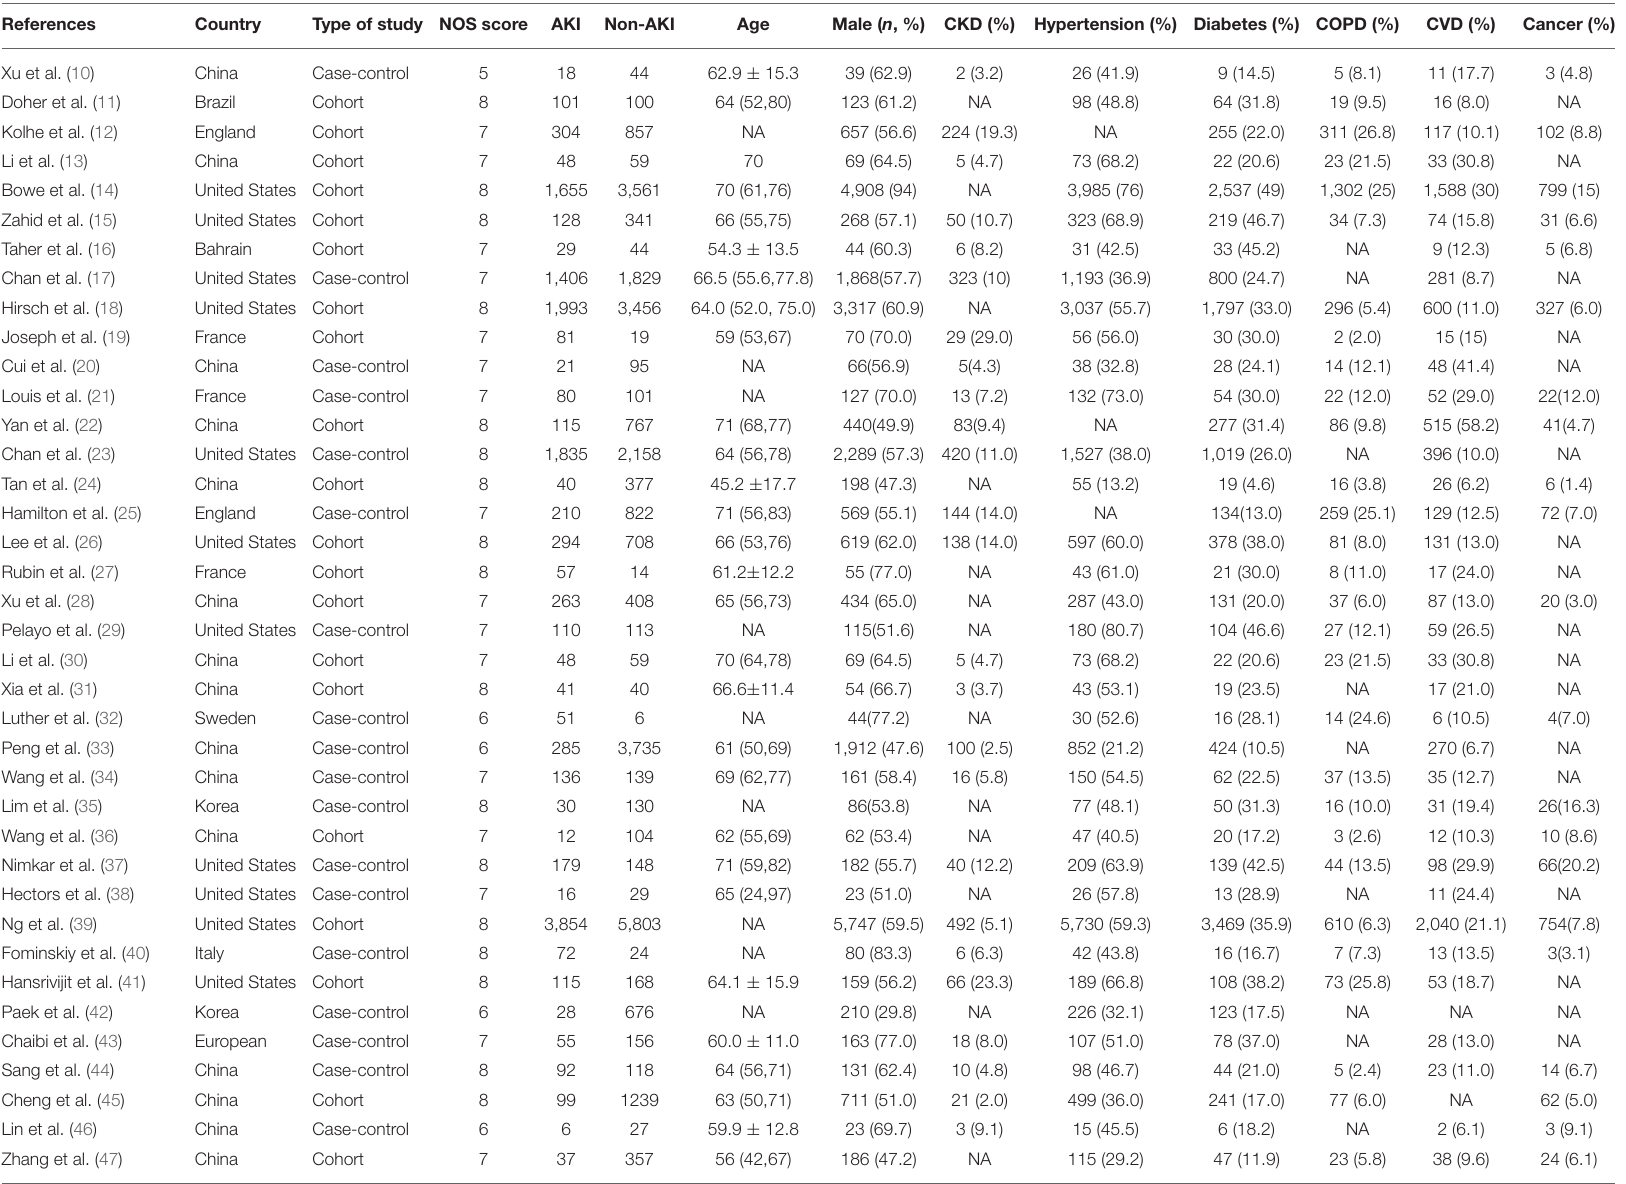
TABLE 2 | Characteristics of the 39 studies included in the